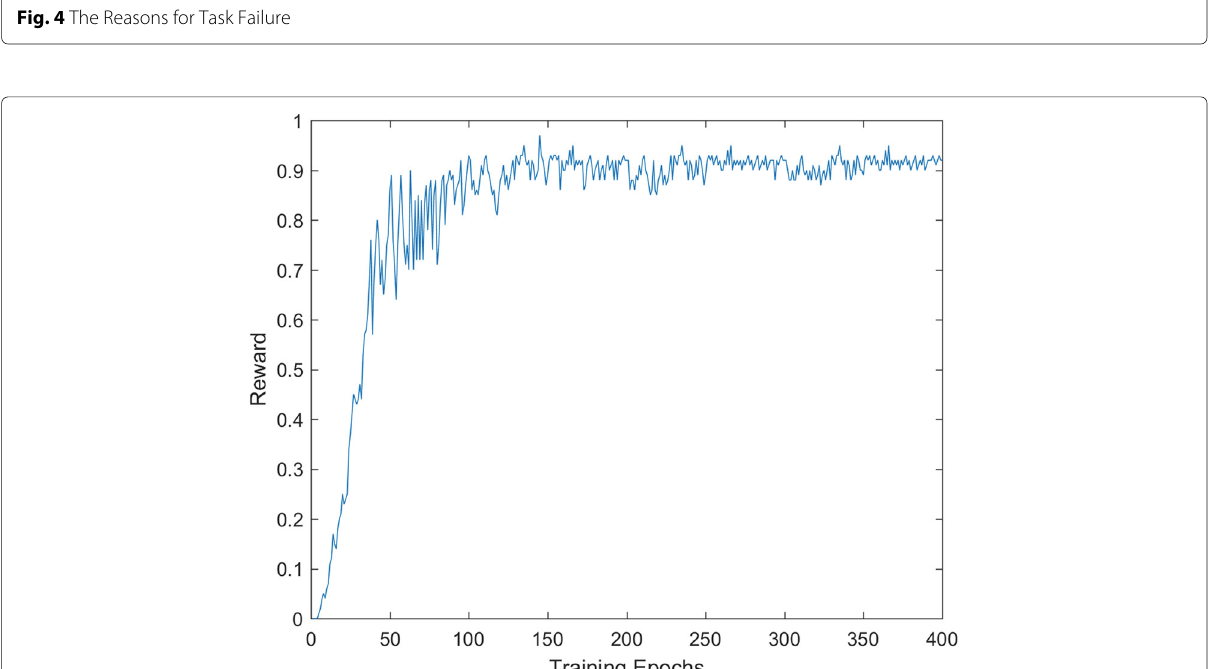
Fig. 5 The Convergence of the proposed DQN-based